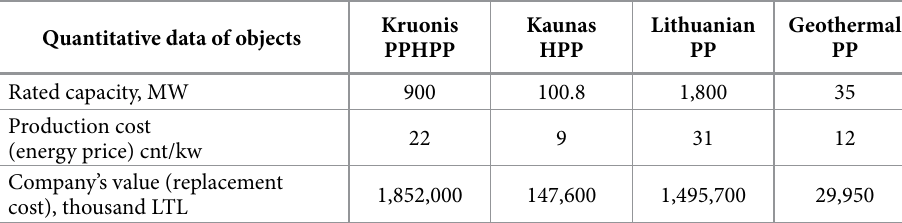
table 4. Quantitative data of the analysed energy sector objects Quantitative data of objects